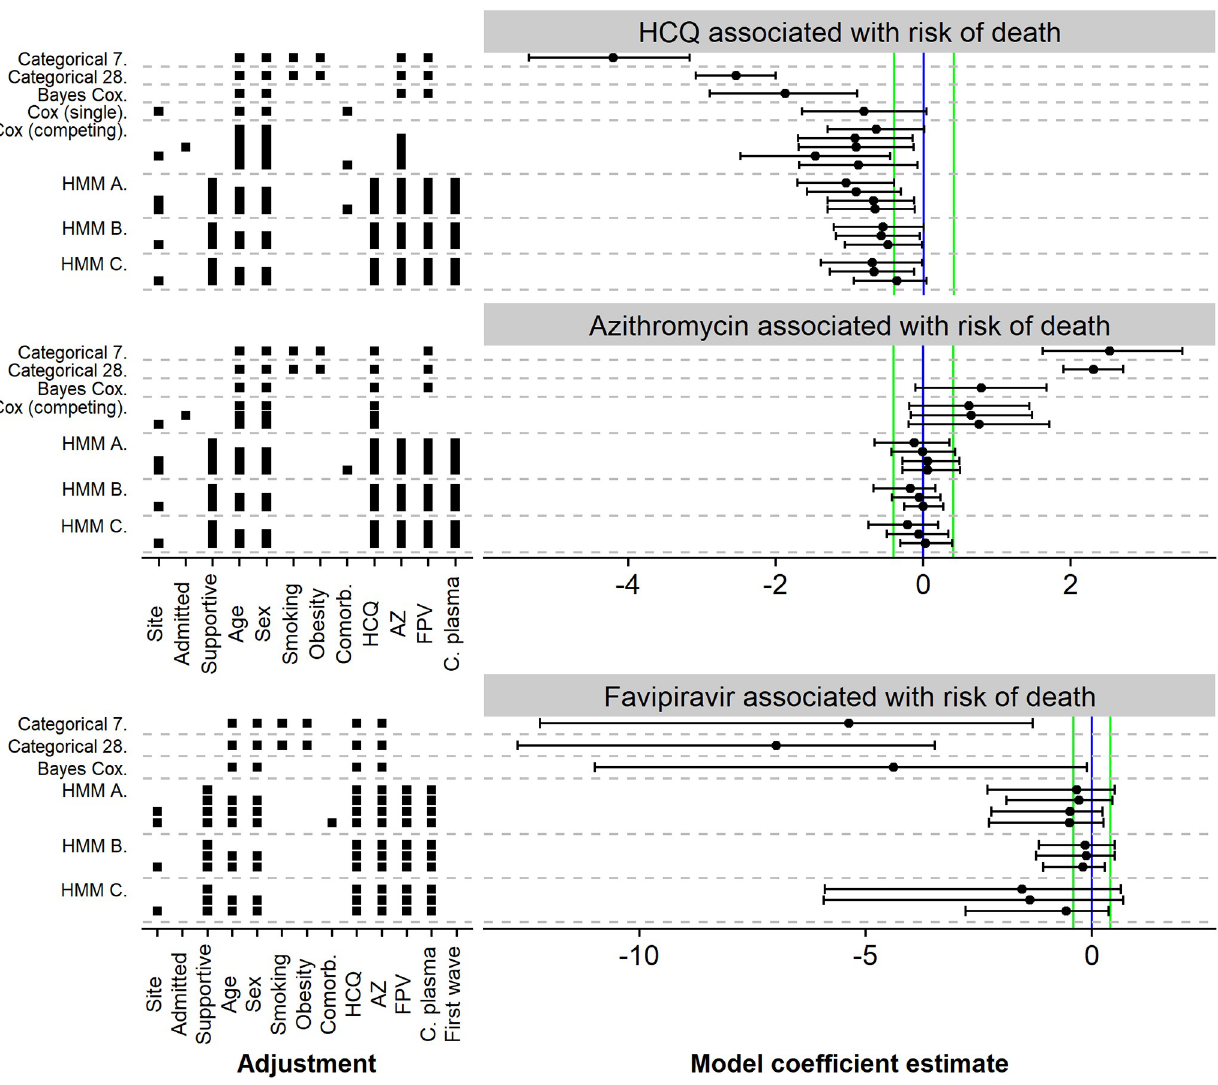
Fig 5. Estimates of model coefficients for association between treatments and main outcomes. Each row represents a model—Categorical 7/ 28 = Bayesian categorical regression for state at day 7/28, Bayes Cox = Bayesian version of the Cox proportional hazards model with a binary outcome, Cox (single) = frequentist Cox model with a binary outcome, Cox (competing) = frequentist Cox model using competing risks (as in Fig 1a), HMM A = Bayesian hidden-Markov model as in Fig 1b with predictors for rate groups, HMM B = Bayesian hidden-markov model as in Fig 1b with predictors for individual rates, HMM C = Bayesian hidden-Markov model as in Fig 1c. For frequentist models, we show maximum likelihood estimate and 95% confidence interval, for Bayesian models we show posterior mean and 95% credible interval. The estimands are either log odds-ratio (Categorical, HMM) or log hazard ratio (Cox variants). In all cases coefficient < 0 means better patient outcome in the treatment group. Vertical lines indicate zero (blue) and substantial increase or decrease with odds or hazard ratio of 3:2 or 2:3 (green). Additionally the factors the model adjusted for are listed—Site = the study site, admitted = Admitted for Covid-19, Supportive = best supportive care initiated, Comorb. = total number of comorbidities, AZ = took azithromycin, HCQ = took hydroxychloroquine, FPV = took favipiravir, C. plasma = received convalescent